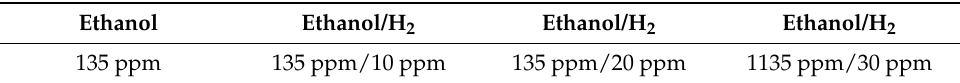
Table 2. Further gas samples for